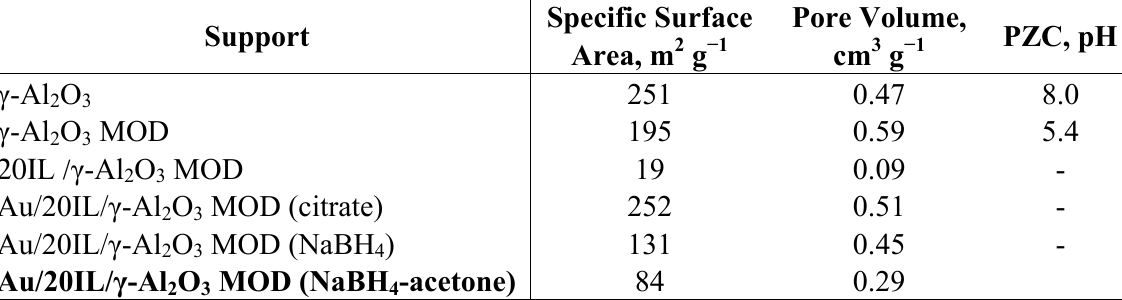
Table 1. Support and catalysts